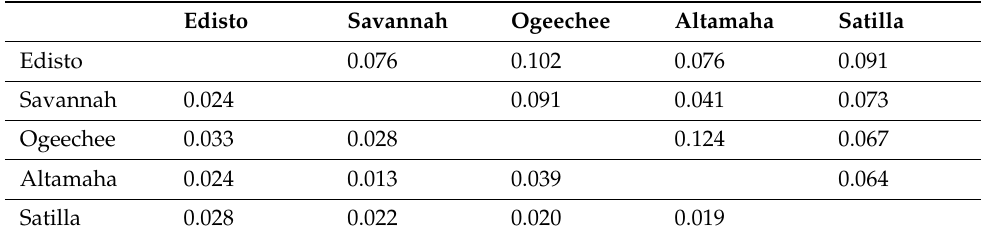
Table 1. F (cid:48) ST and F ST pairwise comparisons of allelic differentiation at 11 microsatellite loci among the composite Edisto, Savannah, Ogeechee, Altamaha, and Satilla river collections in the South Atlantic DPS. F 1 ST comparisons are above the diagonal, and F ST comparisons are below. All comparisons are significant at the p < 0.001 level.